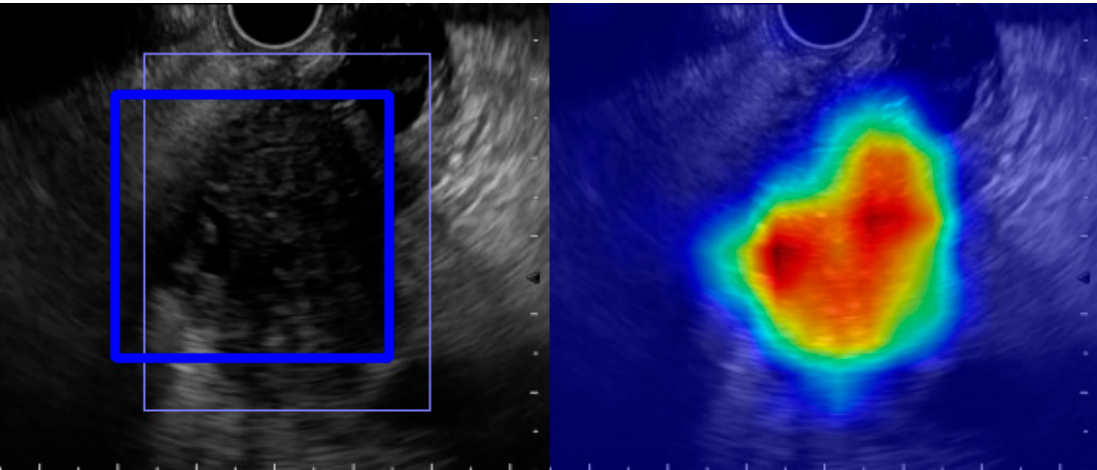
Figure 5. Gradient-weighted lass activation mapping (Grad-CAM). The left image is a representative original endoscopic ultrasound image. The right is a Grad-CAM image displaying the regions recognized as being important.